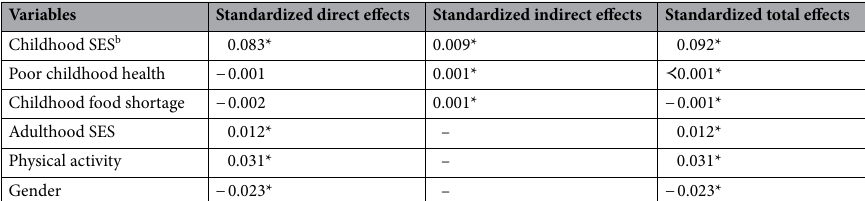
Table 4. Standardized direct effect, indirect and total effect of the variables on late-life T2D a prevalence. a Type 2 diabetes; b Socioeconomic status. * p <